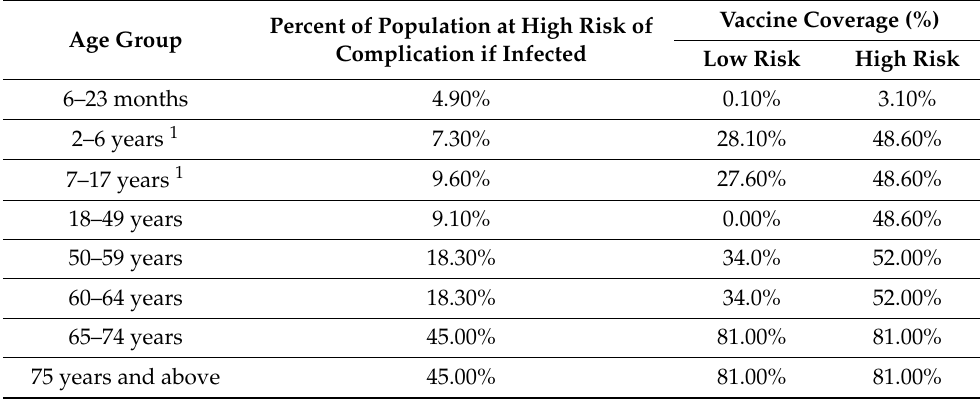
Table 1. Vaccine coverage